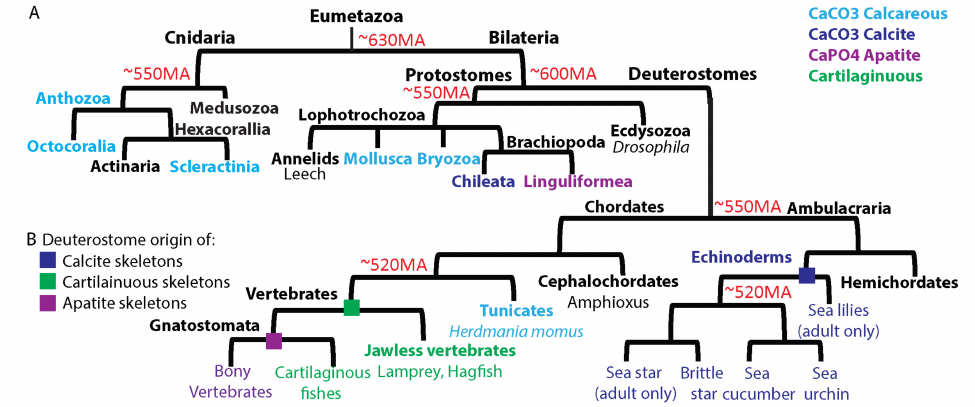
Figure 1. Partial Eumetazoan phylogenetic tree containing phyla and species discussed in this paper and their biomineralization programs. ( A ), calcification in cnidarian and protostome phyla. Numbers in red is the estimated time of divergence in million years (MA) based on [27,29]. Light blue indicates the usage of different CaCO3 polymorphs including but not limited to calcite, aragonite or vaterite. Dark blue indicates the usage of calcite, and purple indicates the usage of apatite. Black indicates non-mineralizing species. ( B ), skeleton formation in deuterostomes. Color code as in ( A ), with the addition of green, indicating the usage of cartilage by the skeletogenic tissue. Squares indicate the evolutionary origin of a specific skeletal